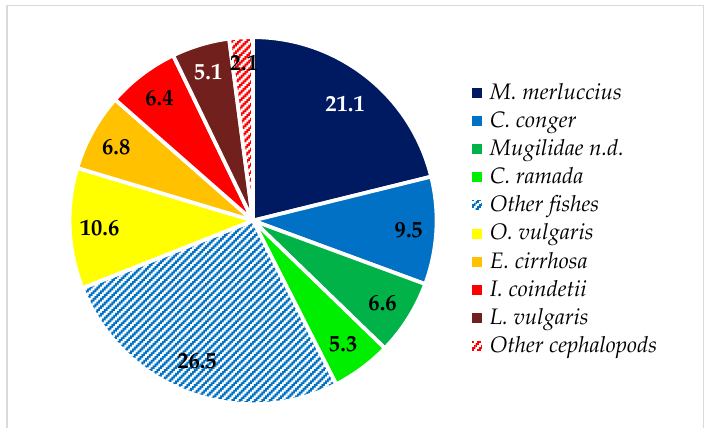
Diversity 2023 , 15 , 21 Figure 4. Weight percentage of main prey species found in T. truncatus stomachs.